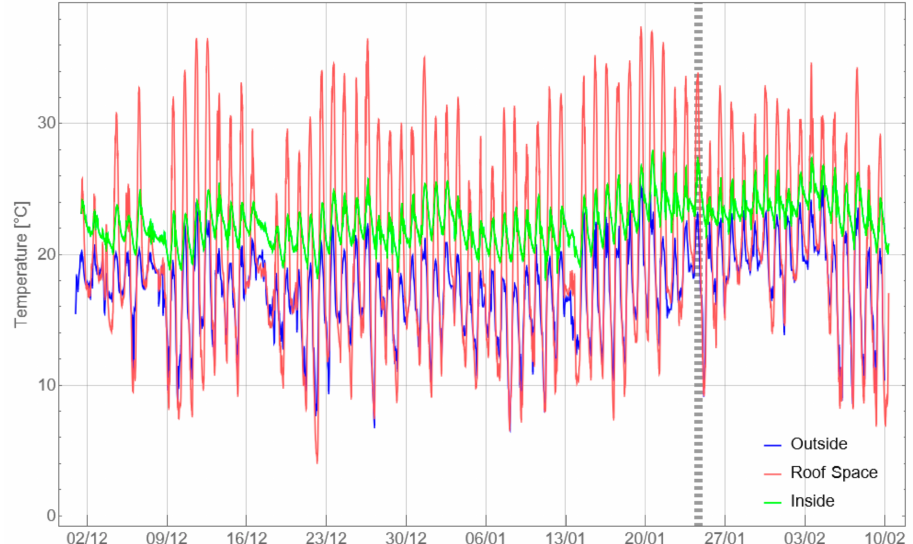
Figure 4. Temperature data from the case study dwelling during the southern hemisphere summer. The outside, roof cavity and living room data are given. The vertical dashed line represents the installation of the daytime only roof